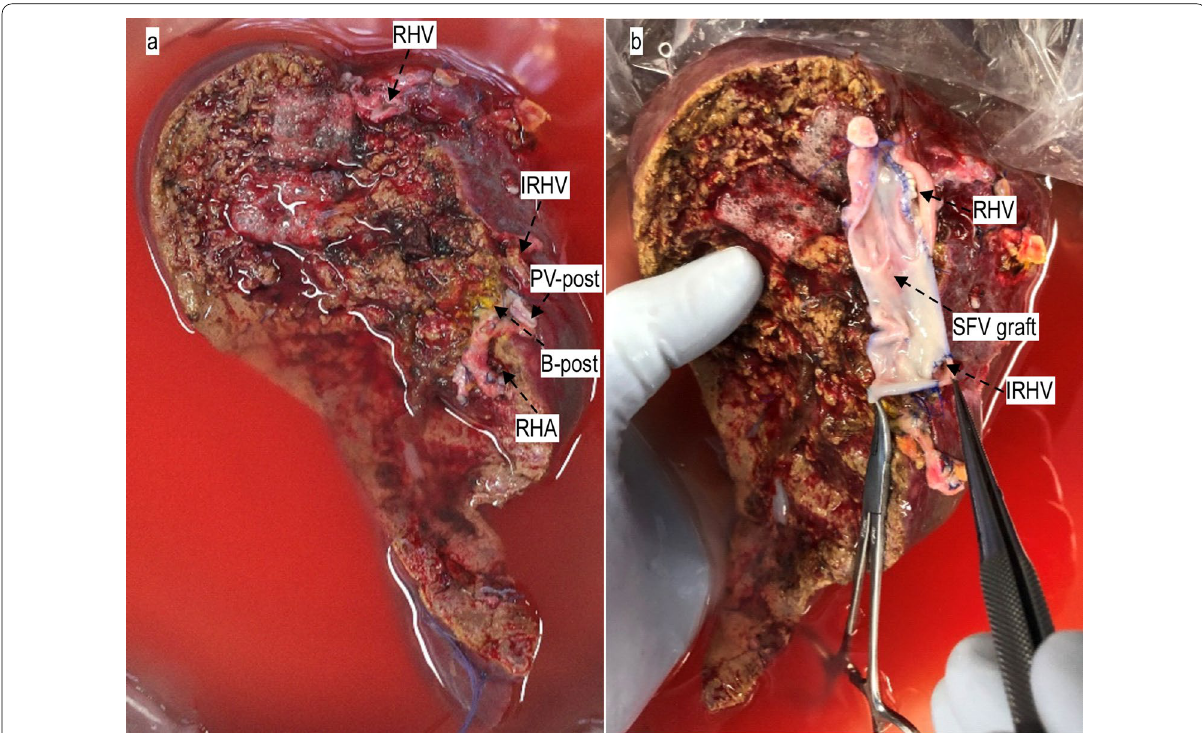
Fig. 3 Right posterior segment graft before ( a ) and after ( b ) anastomosis to the SFV graft. Abbreviations: B-post, posterior branch of right hepatic bile duct; IRHV, inferior right hepatic vein; PV-post, posterior branch of right portal vein; RHA, right hepatic artery; RHV, right hepatic vein; SFV, superficial femoral